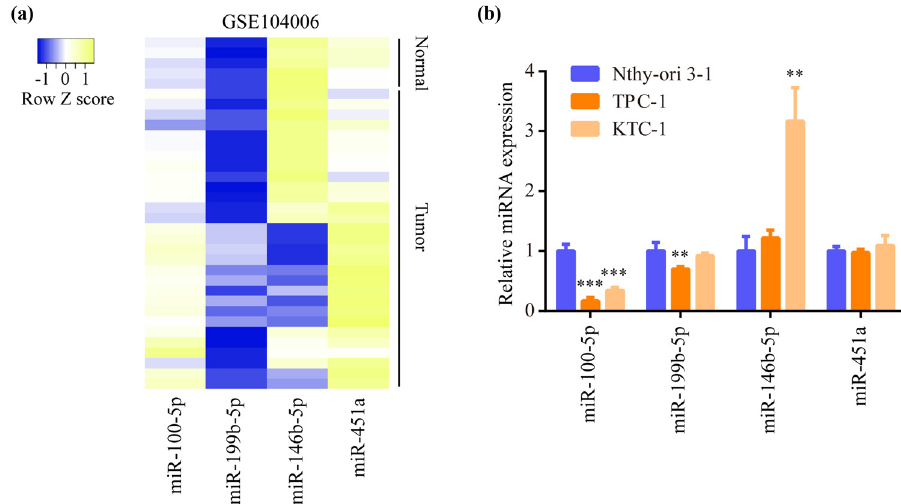
Figure 1: miR - 100 - 5p was one of the di ff erentially expressed miRNAs in PTC: ( a ) Microarray data of fi ve non - neoplastic thyroid tissues and 29 PTC tissues ( GSE104006 ) were downloaded, and the di ff erentially expressed miRNAs were analyzed. Heatmap showed the top four di ff erentially expressed miRNAs between two groups. ( b ) RT - PCR exhibited the expression di ff erence of miR - 100 - 5p, miR - 199b - 5p, miR - 146b - 5p, and miR - 451a among TPC - 1, KTC - 1, and Nthy - ori3 - 1. **, p < 0.01 and ***, p <